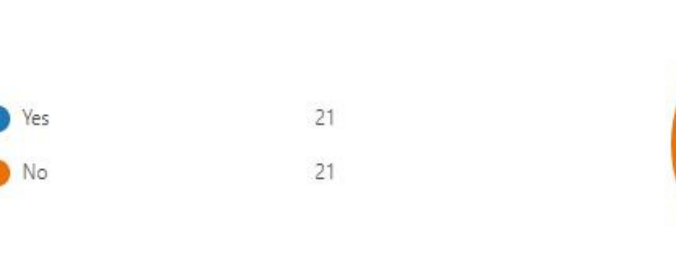
Figure 2. Pie chart showing whether participants would prefer to sit the case presentation exam online.